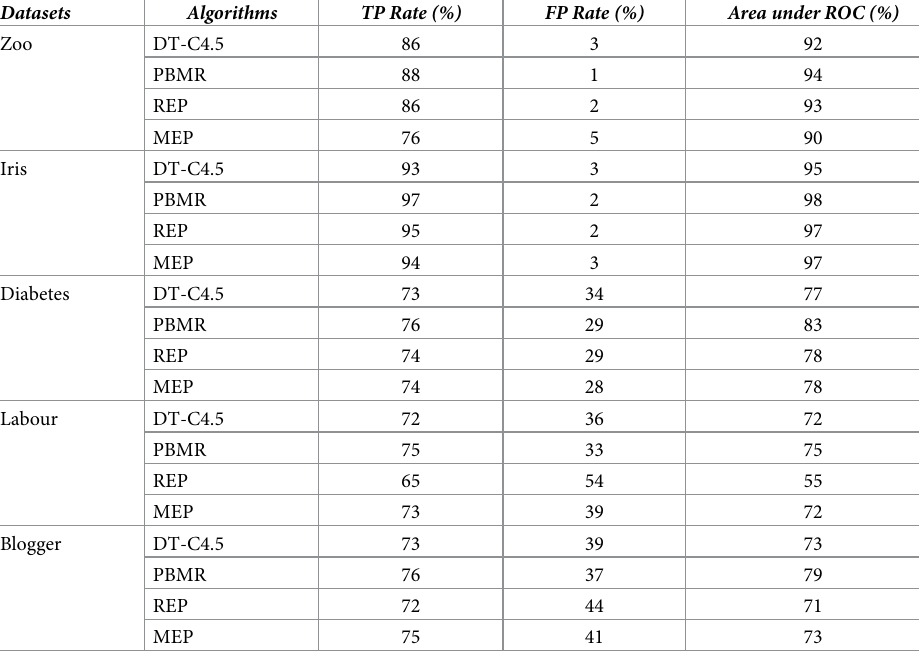
Table 10. TP rate, FP rate, and area under ROC for PBMR, REP, and MEP